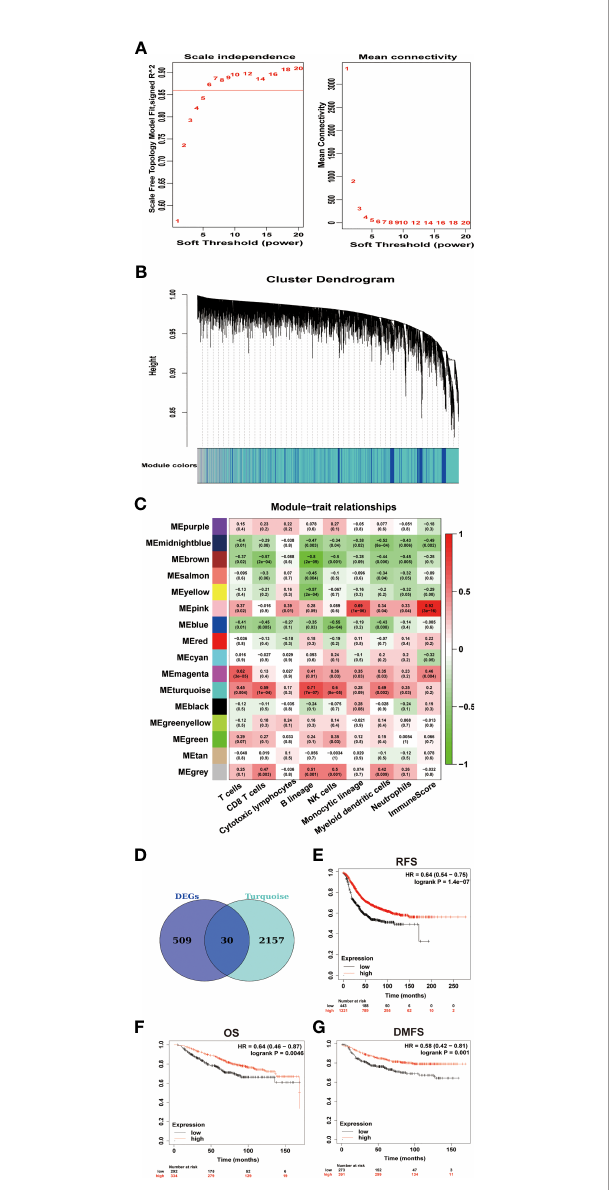
FIGURE 3 | Identi fi cation of signatures associated with immune in fi ltration of BCBMs. (A) Analysis of network topology of GSE43837 dataset with different soft thresholds. The left panel shows the in fl uence of soft threshold power (x- axis) on the scale-free fi t index (y-axis). The right panel shows the in fl uence of soft threshold power (x-axis) on mean connectivity (y-axis). (B) Dendrogram of gene clustering, the gene set was divided into 16 modules based on network topology. Different color modules contain different number of genes. (C) Heatmap shows correlations of module eigengenes with immune cell in fi ltration. Each cell contains the corresponding correlation and P value. (D) Venn diagram of DEGs and turquoise module eigengenes. A total of 30 overlapping genes were obtained. The full DEGs lists are provided in Supplementary Table 1 . The 30 overlapping genes are provided in Supplementary Table 4 . (E – G) Prognostic signi fi cances of IM-metagene in patients with breast cancer were shown based on the KM plotter database. RFS, relapse ‐ free survival; OS, overall survival; DMFS, distance metastasis free survival; and HR, hazard ratio. The P values were determined using a log- rank